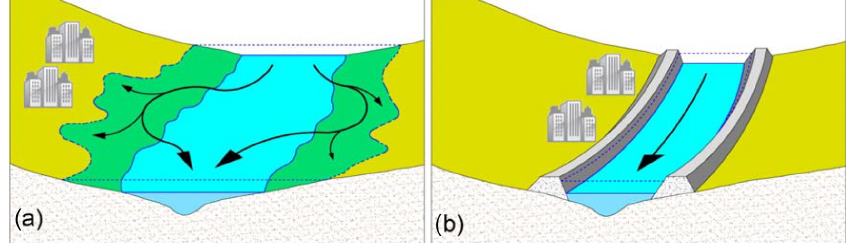
Figure 1. Schematic of human adjustments to flooding – (a) adaptation: settling away from the river, and (a) fighting: raising levees or dikes (after Di Baldassarre et al.,